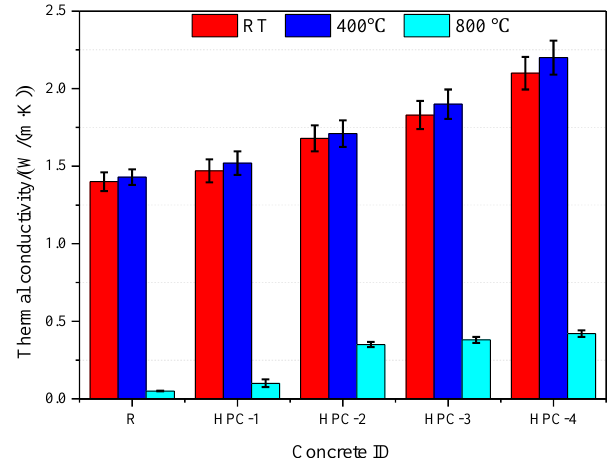
Figure 5. Thermal conductivity of concrete subjected to high temperatures.